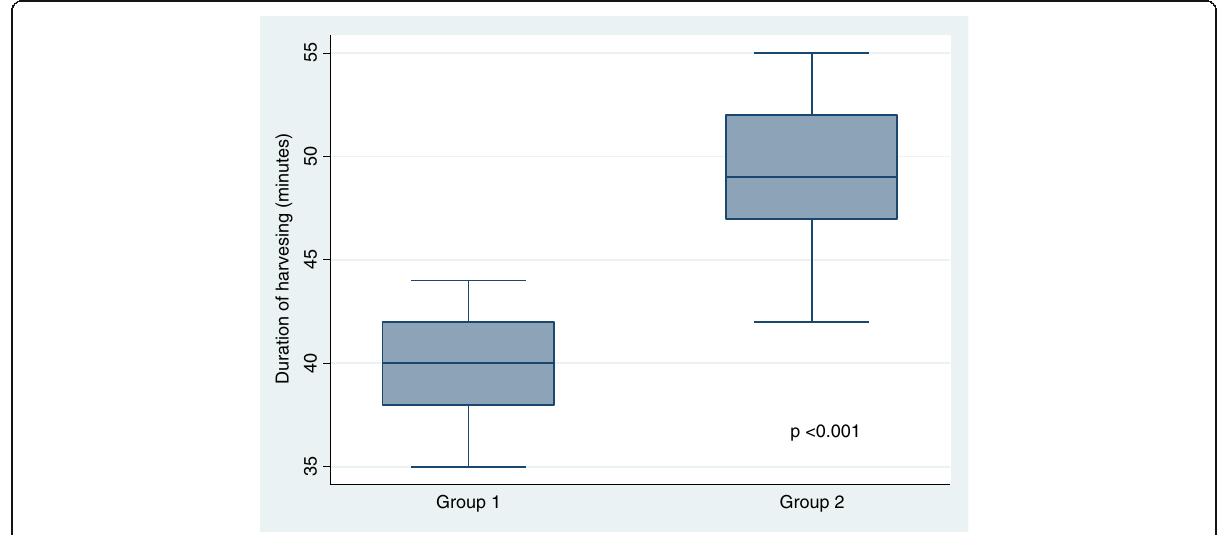
Fig. 3 Comparison of the harvest time between both groups